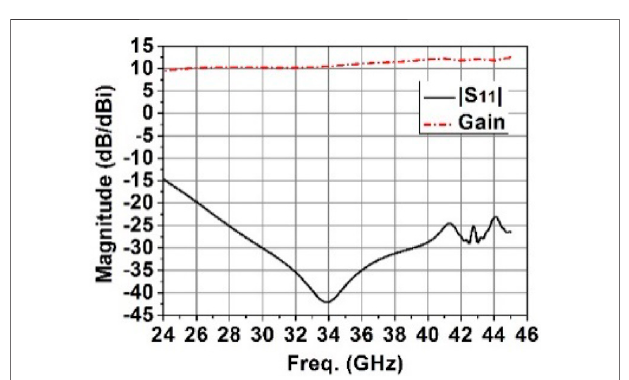
FIGURE6| Simulatedresultsoftheproposedcorrugatedhornantenna.